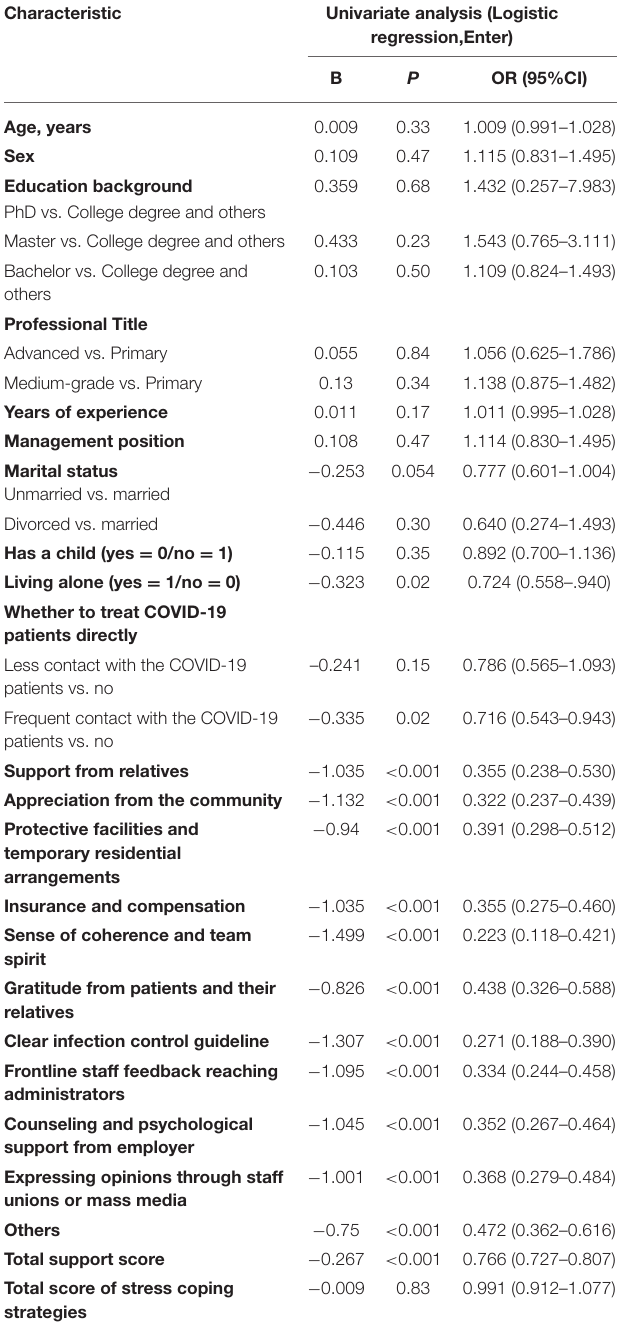
TABLE 9 | Characteristics associated with psychological distress among 1,364 Chinese nurses during the COVID-19 pandemic. Characteristic Univariate analysis (Logistic